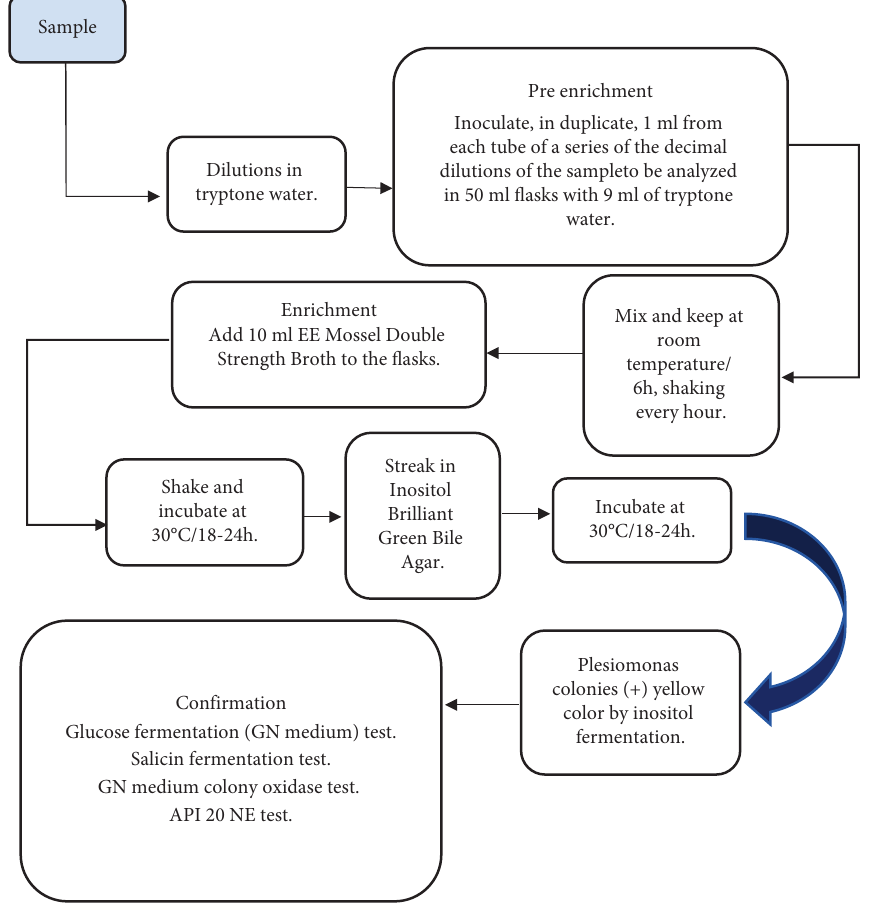
Figure 2: Presence-absence test with enrichment in selective medium